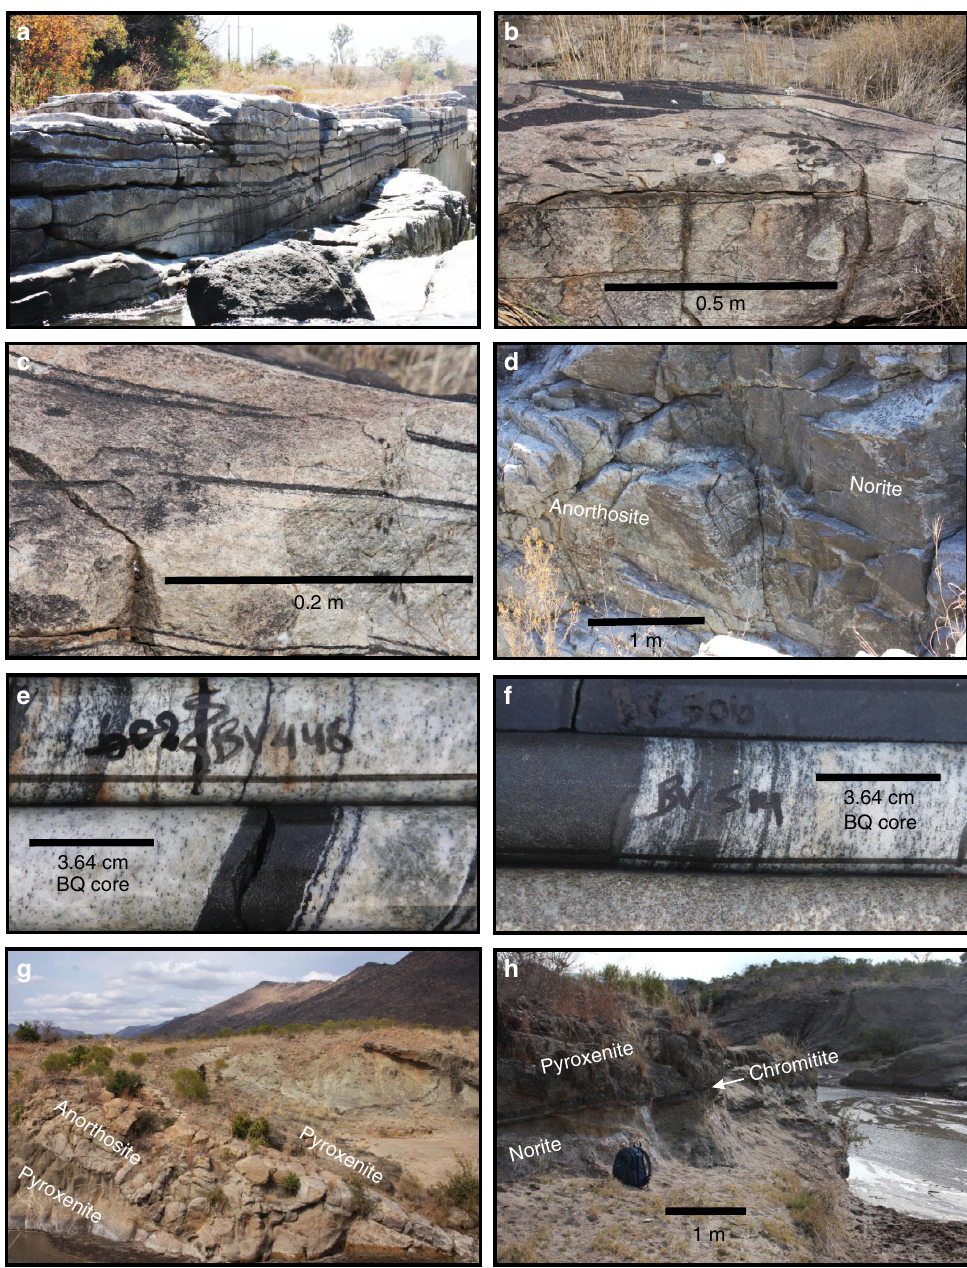
Figure 5 | Photographs of key contact relations. ( a – d ) show the lower part of the UG1 Unit and its footwall at the Dwars River UNESCO World Heritage Site; a shows bifurcating layers of chromitite (vertical face in foreground is about 1m high); ( b , c ) show fragments and disrupted laminae of chromitite in anorthosite, however chromite itself commonly contains fragments of anorthosite; d shows norite with wispy irregular layering partially engulfed by mottled anorthosite in ‘migmatitic’ texture. e and f show similar interlayered chromitite and anorthosite in the TF3 borehole at the bases of the UG1 and MG4A Units, respectively. g and h are photographs from the Marginal Zone in the Madiseng area near Burgersfort. g shows stacked pyroxenite sills separated by anorthosite (24.633 (cid:2) S, 30.197 (cid:2) E), with the pyroxenites of the Lower Zone above in the distance. The rock face is about 3m high. h shows a pair of thin chromitite seams forming the base of a layered pyroxenite-norite sill overlying norite (24.636 (cid:2) S, 30.202 (cid:2) E) a few tens of metres structurally beneath and 500m east of the outcrop shown in g . Backpack is shown for